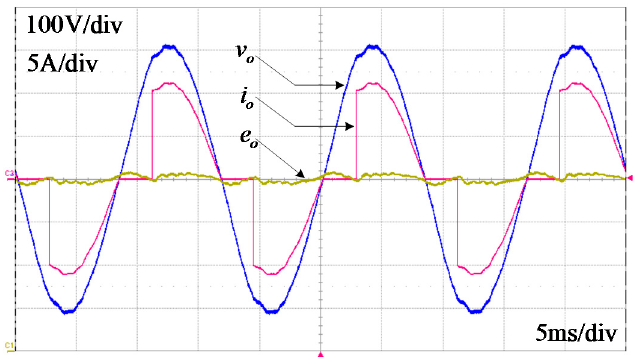
Figure 18. Experimental result with the active damping control.